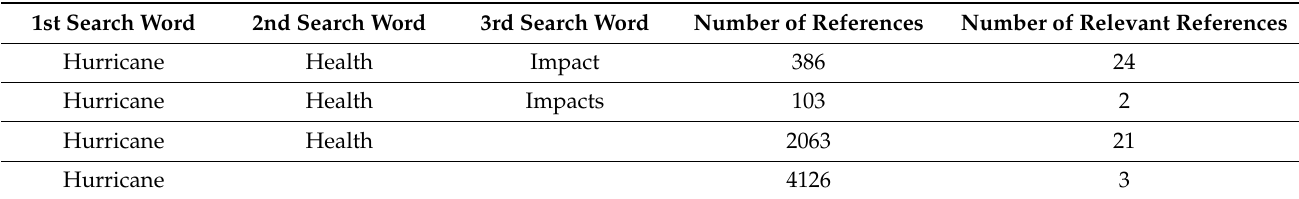
Table 1. The literature search key terms, results and relevant references.